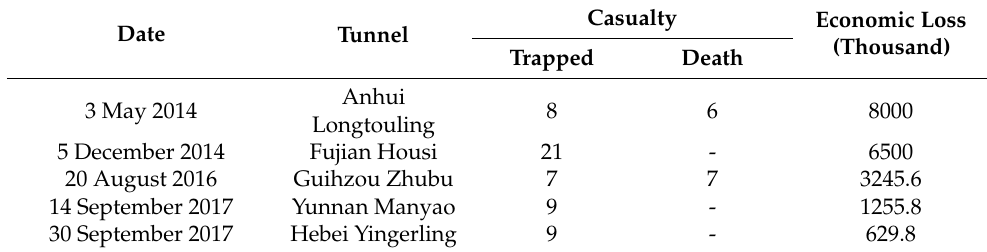
Table 1. Collapse accidents of tunnels under